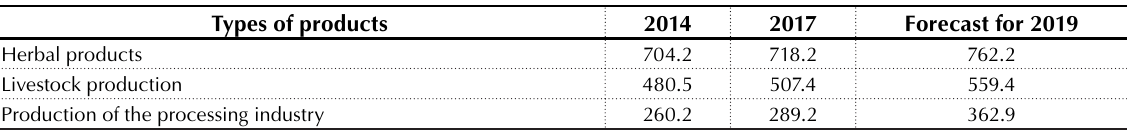
Table 2. Value of Ukrainian exports of agrarian products Ukraine to EU, mln.